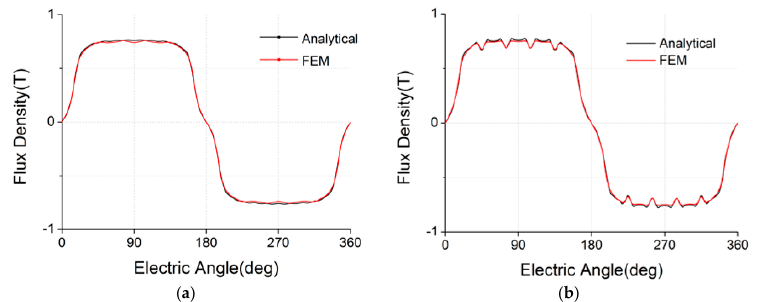
Figure 5. Air gap flux density caused by permanent magnet. ( a ) In the slotless air gap; ( b ) In the slotted air gap.